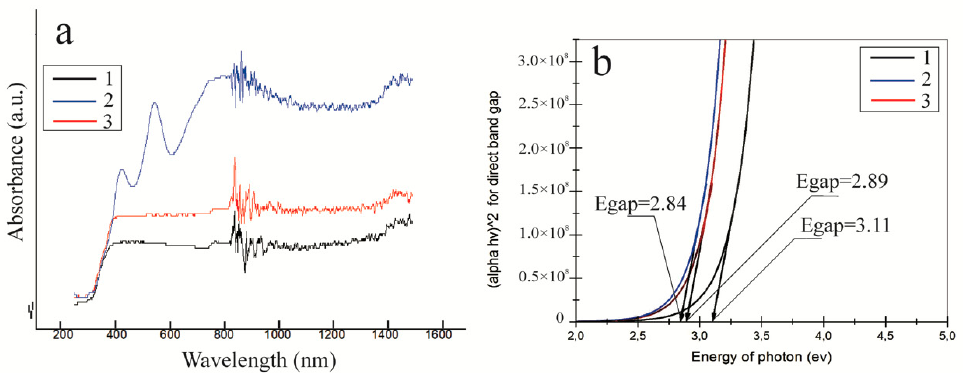
Figure 3. Absorption and reflection spectra ( a ) and values of the bandgap ( b ) of synthesized composite photocatalysts: SrTiO 3 / PAN / Fe 2 O 3 —1 (black line); SrTiO 3 / PAN / CuO—2 (blue line); and SrTiO 3 / PAN / Cr 2 O 3 —3 (red line) .